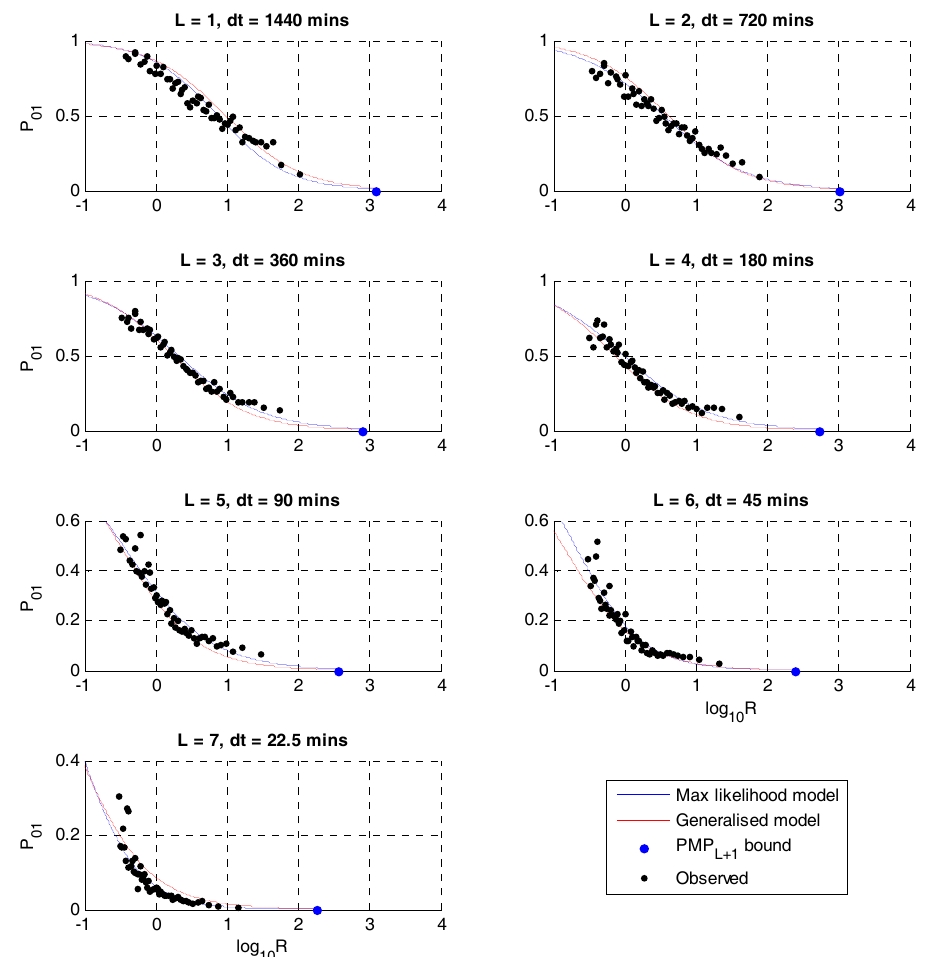
Figure 2. Volume dependence of P 01 for the unbounded model.